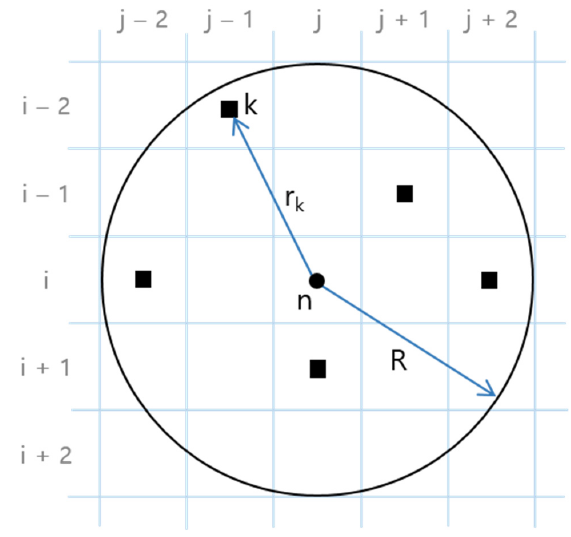
Figure 6. Structure of data assimilation .